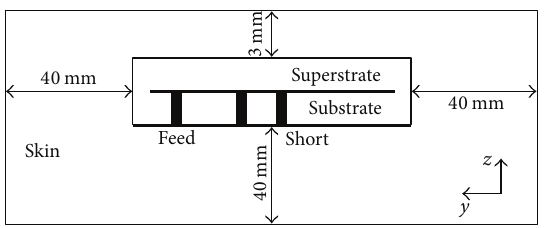
Figure 2: Side view of simulation